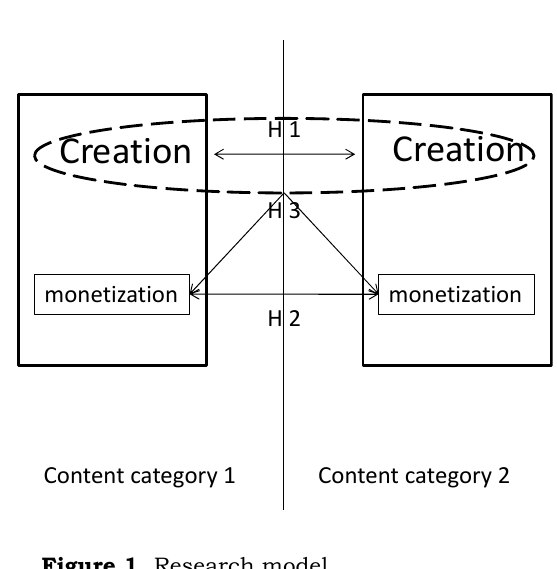
Figure 1. Research